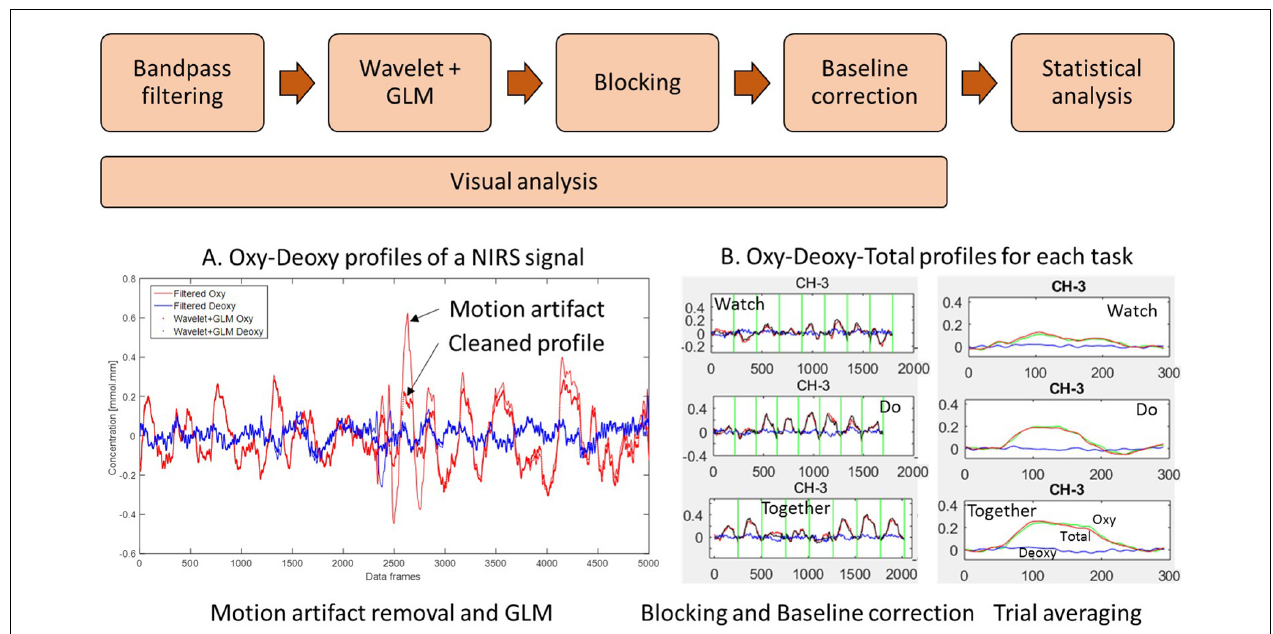
FIGURE 3 | Data processing workflow: (A) filter, wavelet and general linear model (GLM) of NIRS signal and (B) trial-by-trial view and Average view of Oxy Hb (HbO 2 ), Deoxy Hb (HHb), and Total Hb (HbT) profiles for a given channel. (W, D, T) from 5 s before to 24 s after the start of stimulation. Data have been averaged across trials and participants.